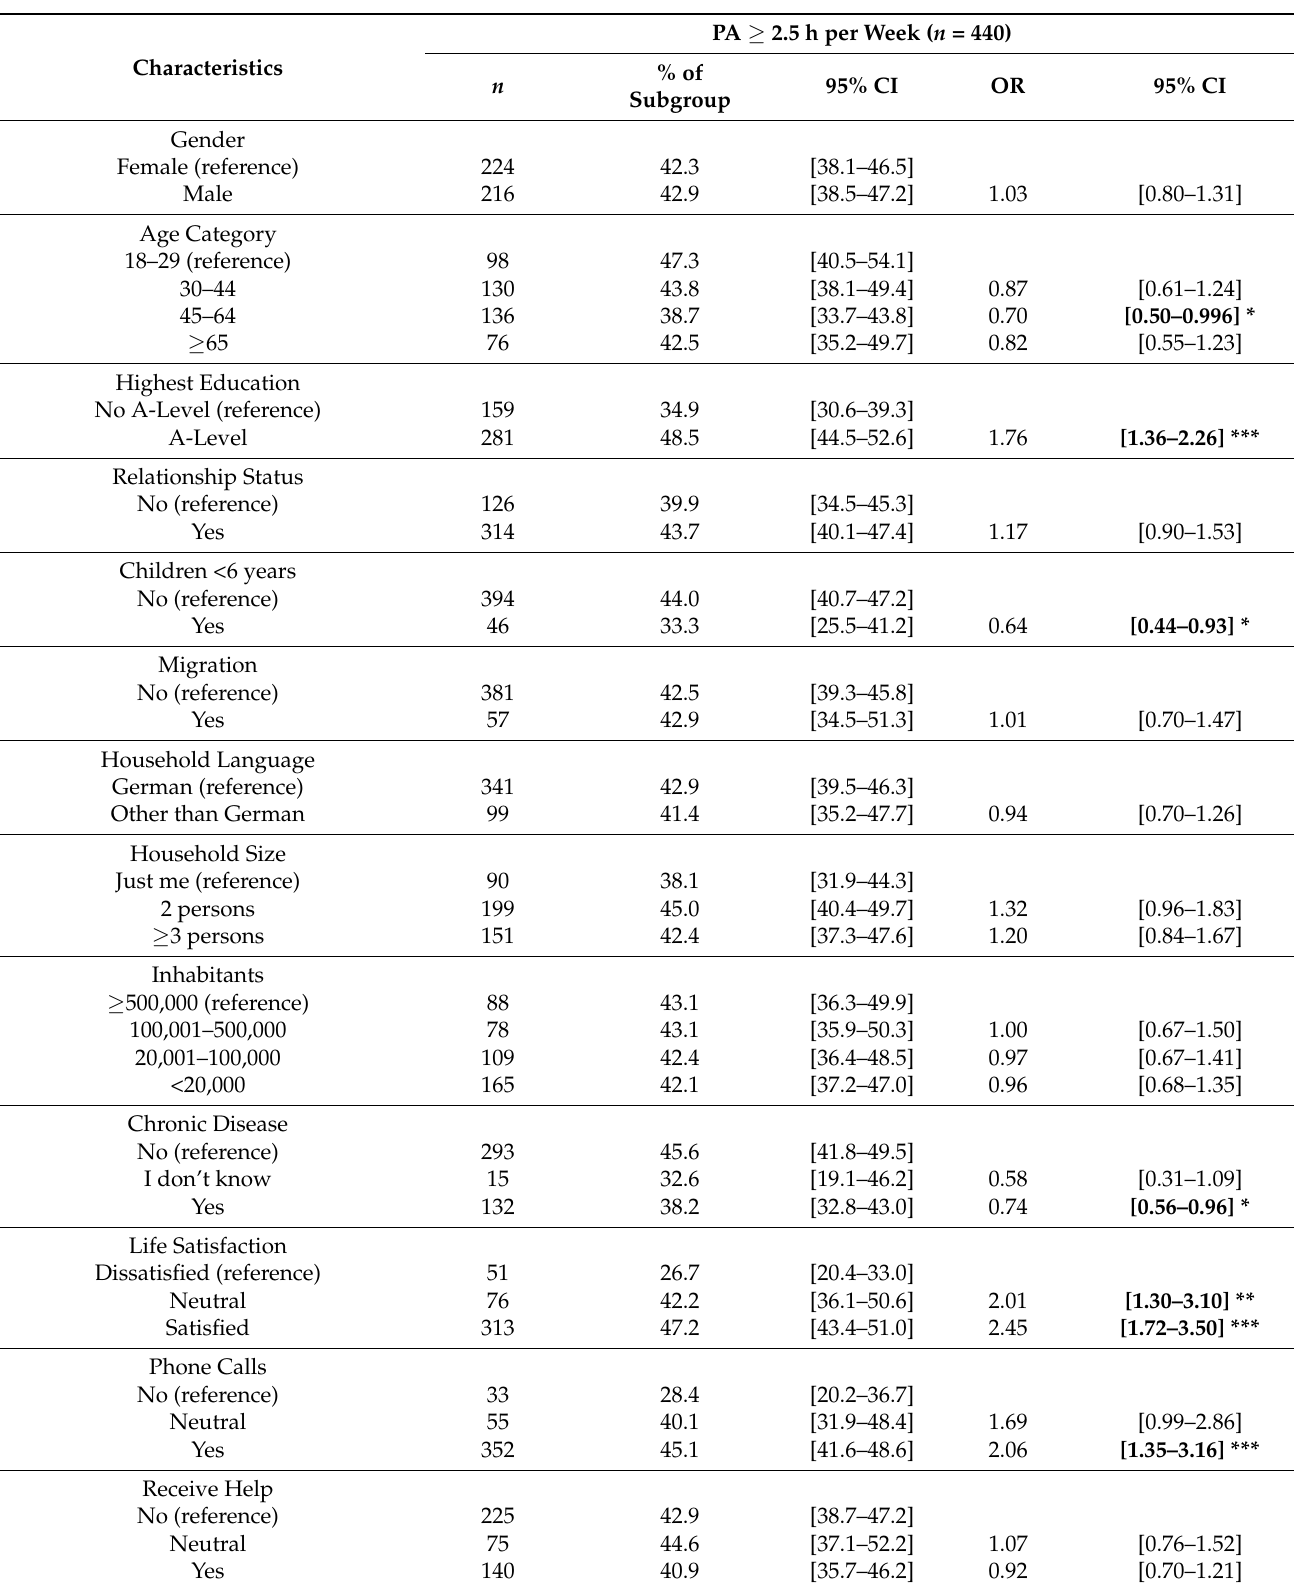
Table 2. Univariate analysis: absolute and relative frequencies and Odds Ratios—PA ≥ 2.5 h per week.